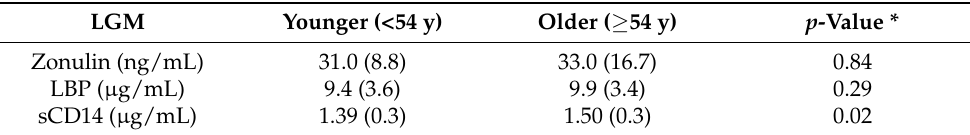
Table 4. LGM levels in the younger ( n = 247) and older ( n = 253) individuals separately. LGM Younger (<54 y) Older ( ≥ 54 y) p -Value * Zonulin